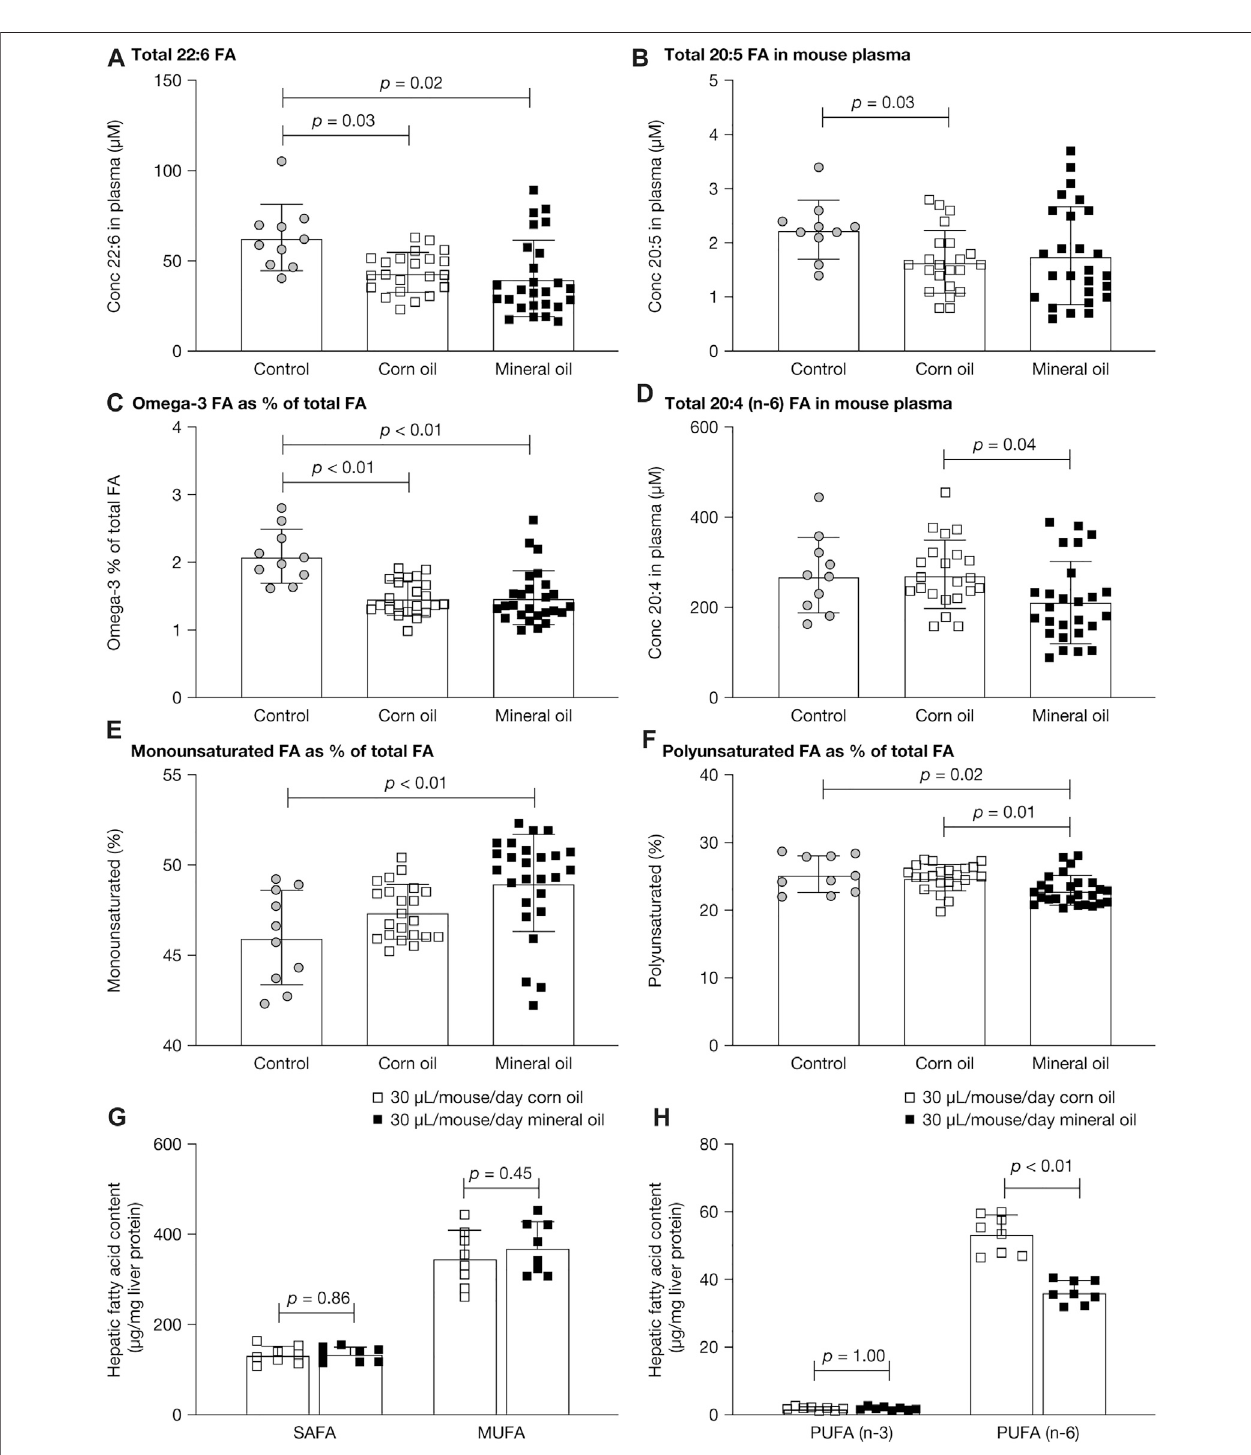
FIGURE5| Plasmaandliverfattyacidsincontrolmiceandmicefedwithcornoil30 µL/mouse/dayormineraloil30 µL/mouse/dayfor12or16 weeks: (A) total22: 6 (docosahexaenoic acid) fatty acid concentration in plasma, (B) total 20:5 (EPA) fatty acid concentration in plasma, (C) Omega-3 index in plasma, (D) total 20:4n6 (arachidonicacid)fattyacidconcentrationinplasma, (E) percentmonounsaturatedfattyacidsinplasma, (F) percentpolyunsaturatedfattyacidsinplasma, (G) SAFAand MUFA in liver, and (H) PUFA n-3 and n-6 in liver. p -values were calculated using independent samples t -test. EPA, eicosapentaenoic acid; FA, fatty acid; MUFA, monounsaturated fatty acid; PUFA, polyunsaturated fatty acid; SAFA, saturated fatty acid.